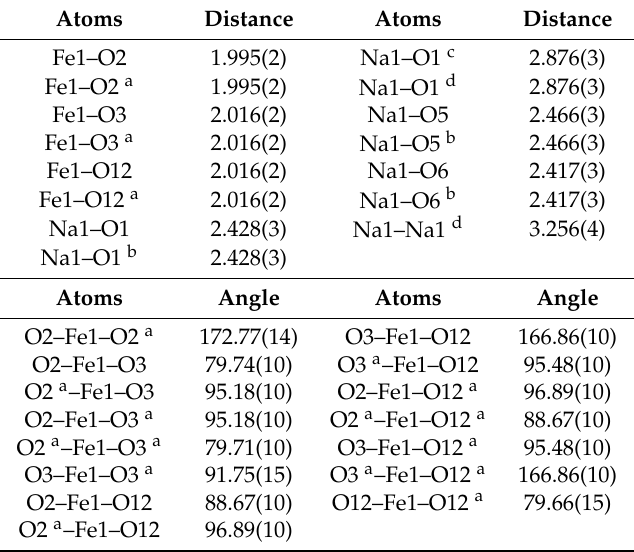
Table 2. Main bond lengths (Å) and angles ( ˝ ) in compound 1